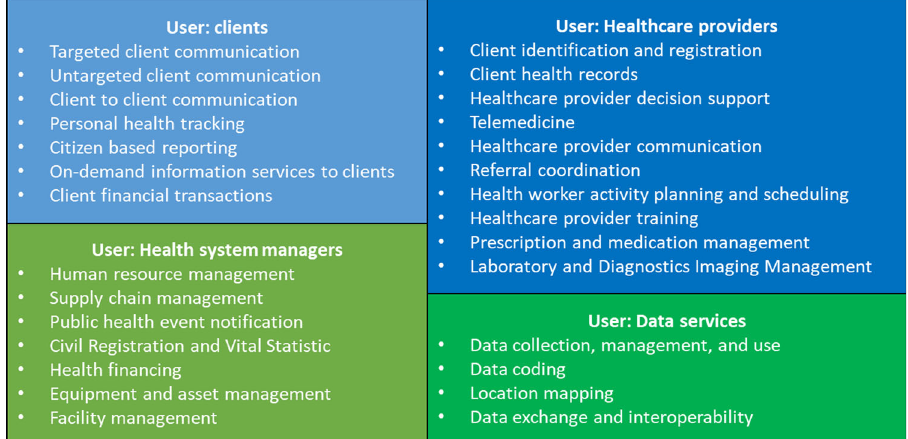
Fig. 4 WHO classi fi cation of digital health interventions, adapted from WHO 2018 4 . The WHO classi fi cation categorized digital health interventions into four groups by different users: clients, healthcare providers, health system managers, and data